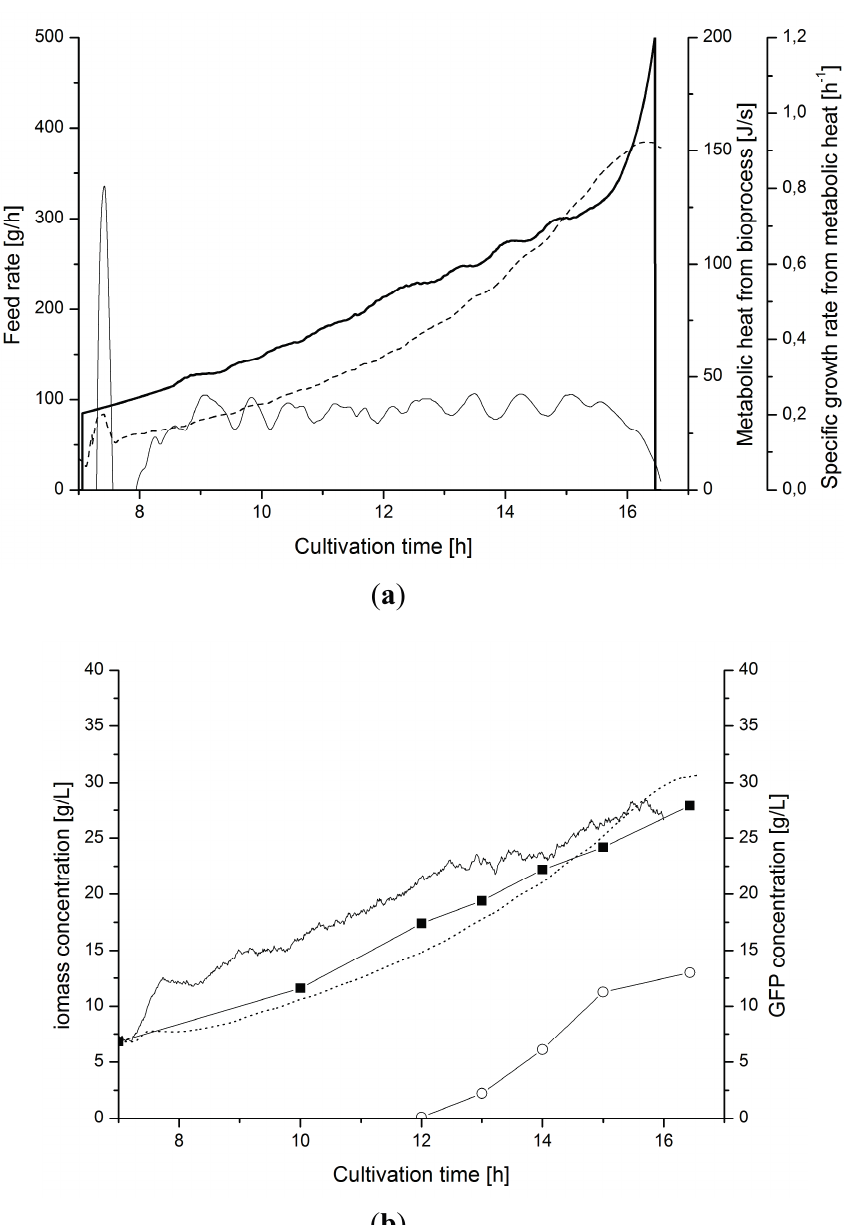
Figure 11. Induced fed-batch cultivation producing recombinant GFP. ( a ) Controlled feed rate ( ), metabolic heat production ( ) and µ metabol ( ⎯ ); ( b ) Biomass from heat ( ⋅⋅⋅⋅⋅ ), optical density ( ■ ) and capacitance measurements ( ⎯ ). The production of GFP ( ○ ) is induced at 12